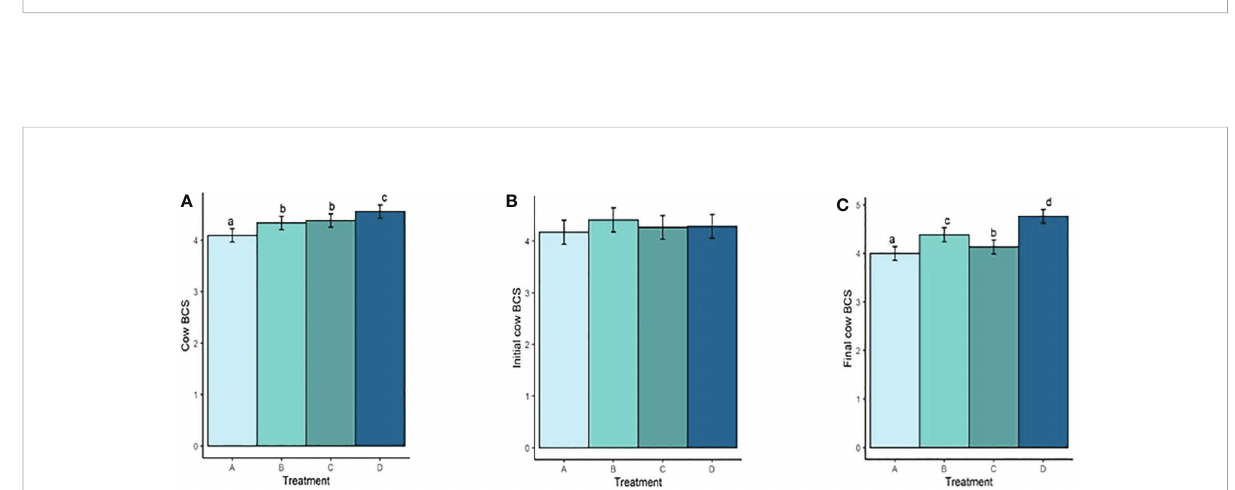
FIGURE 5 (A) Mean cow BCS of treatment groups. (B) Initial cow BCS. (C) Final cow BCS. Treatment A contained 0.00% tea saponin (TS), B contained 0.16% TS, C contained 0.32% TS, and D contained 0.64% TS. Means bearing different letters differ signi fi cantly ( P < 0.05).